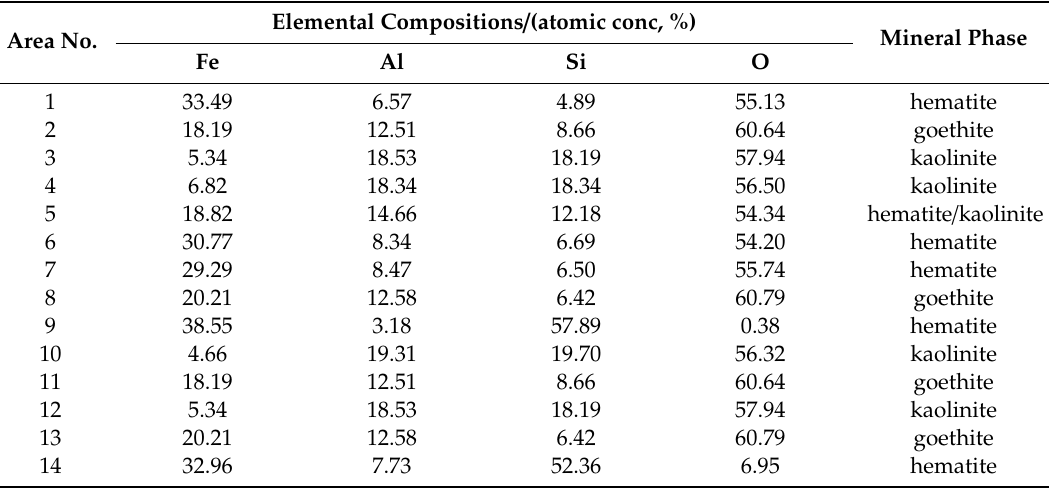
Table 4. The EDS analysis results for areas in Figure 2. Area No.